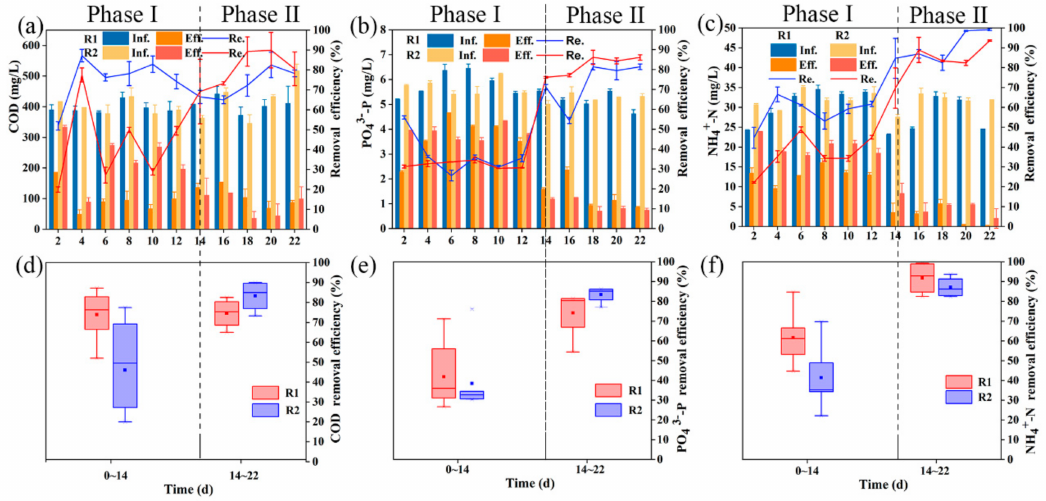
Figure 1. Profiles of influent and effluent concentration, removal efficiency: ( a ) COD; ( b ) PO 3 − of removal efficiency of two group reactors during the reactivation process: ( d ) COD; ( e ) PO 3 − R2: